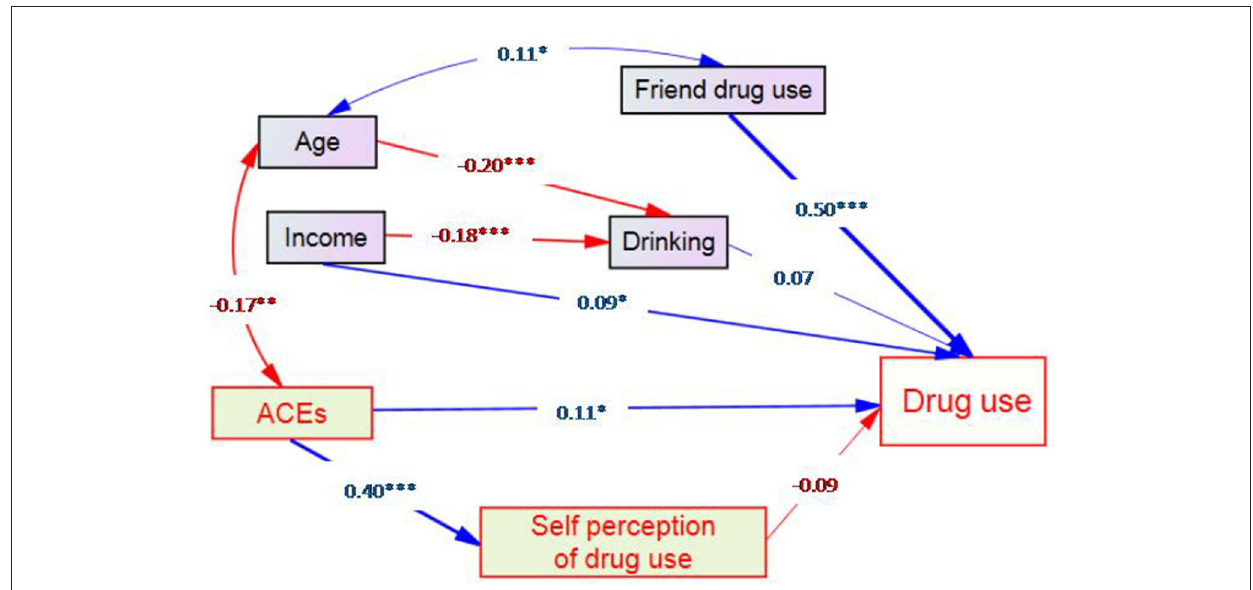
FIGURE2 SEM results showing the pathway of effects of adverse childhood experiences on the poly-drug use pattern among drug-using adults (Note: 1). * p < 0.05, ** p < 0.01 and *** p <